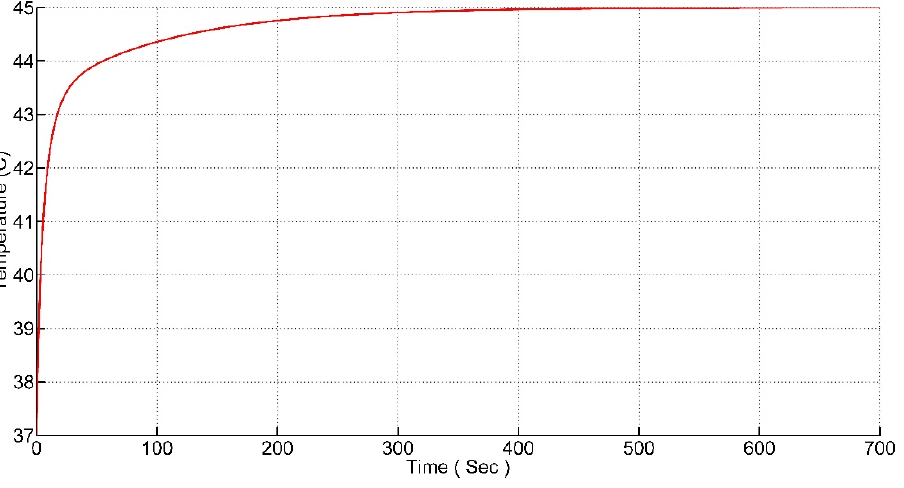
Figure 7. Step Response of PI, PID and PD controllers.